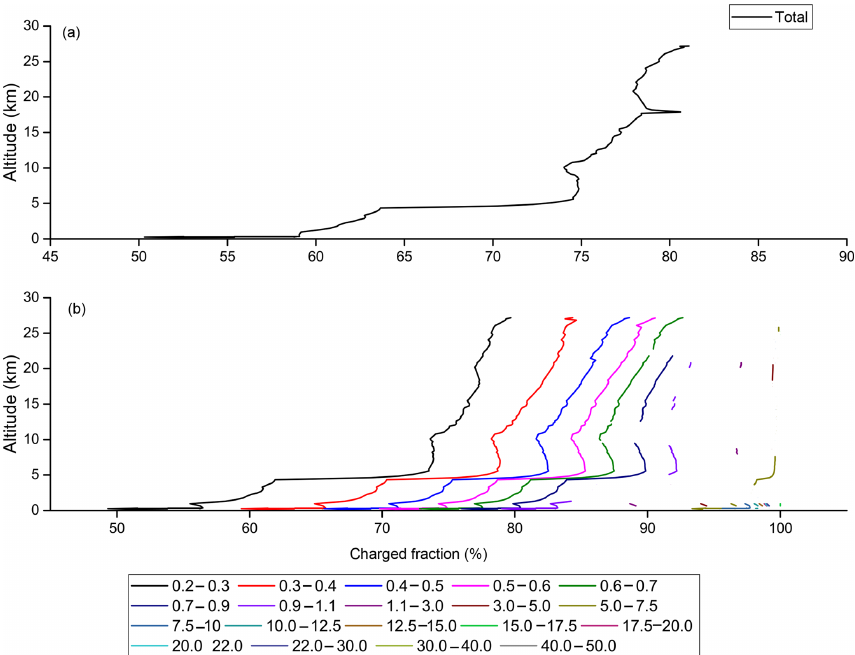
Figure 5. Vertical profile of the simulated fraction of charged particles: (a) total; (b) in the different size classes. Because of the very low and even zero concentration particles in the largest size classes, only particles with diameter smaller than 5µm are considered. Table 1. Spearman’s correlation coefficient between ions and number of particles in the different size classes. The asterisk * indicates significant (0.05 significance level, i.e., p< 0 . 05) correlation coefficients; bold indicates strong ( R> 0 . 6 in absolute value) correlation, while italics indicate weaker (0 . 4 <R< 0 . 6 in absolute value)